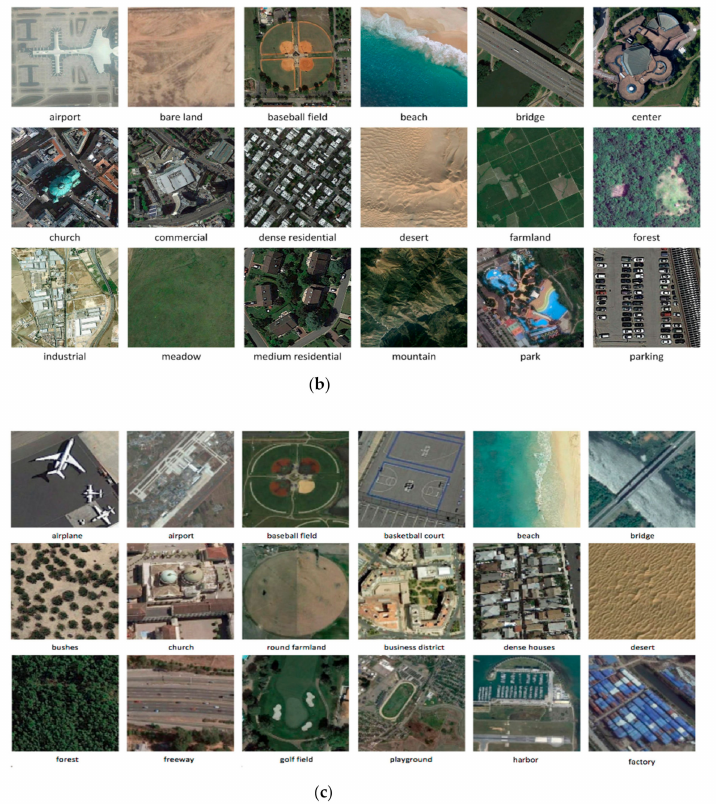
Figure 4. Some example images from ( a ) Merced dataset. ( b ) AID dataset. ( c )